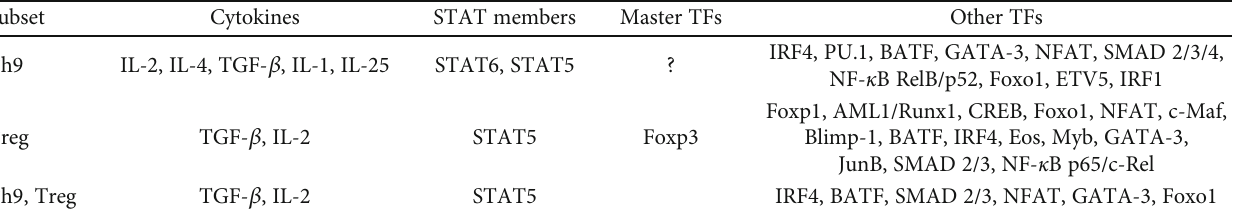
Table 1: Speci fi c cytokines, signal transducer, activator of transcription (STAT) members, and transcription factors (TFs) in the development and di ff erentiation of Th9 cell and Treg